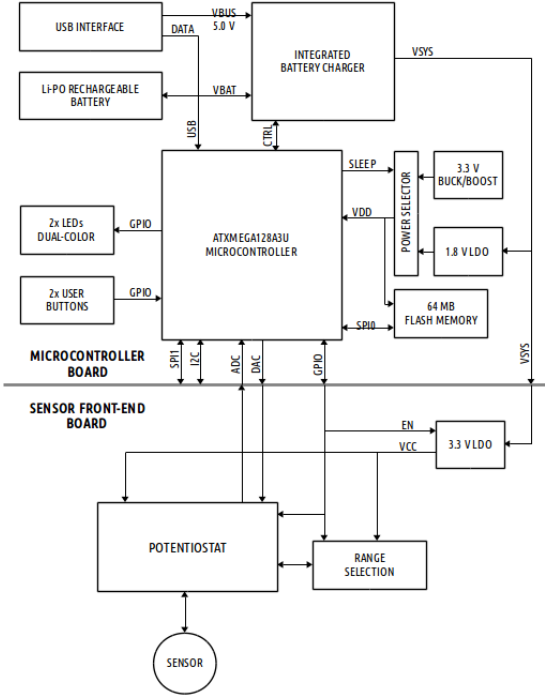
Figure 3. The block diagram of the developed electronic system.